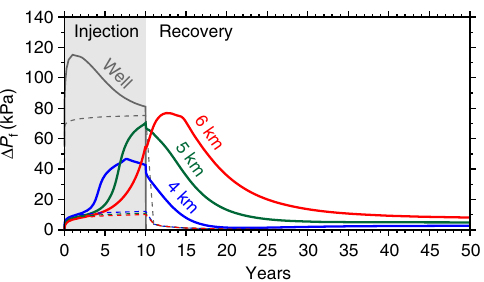
Fig. 3 Time series of fl uid pressure above initial conditions ( Δ P f ). Simulation data are recorded at monitoring points located within the injection well (black) and directly below the well at 4 km (blue), 5 km (green), and 6 km (red) depth. Solid and dashed lines are Δ P f curves for the variable density and constant-density models, respectively. For a given depth, the difference between solid and dashed lines are due to the advective transport of high-